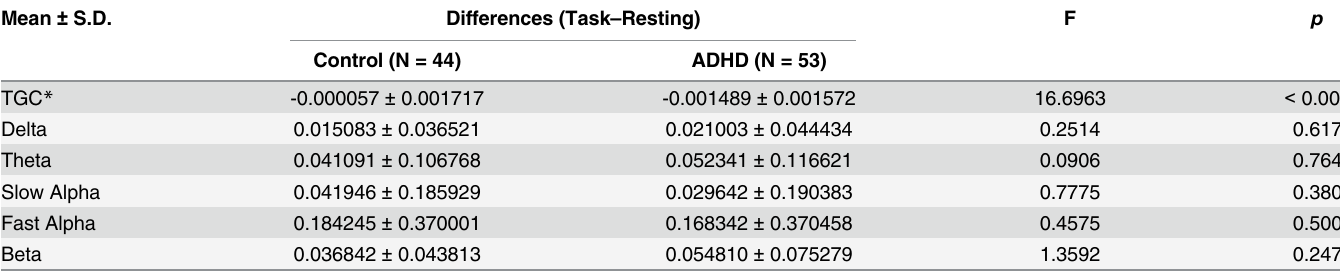
Table 2. Sex-adjusted means of the differences during the arithmetic task between patients with ADHD and normal controls. Mean ± S.D.